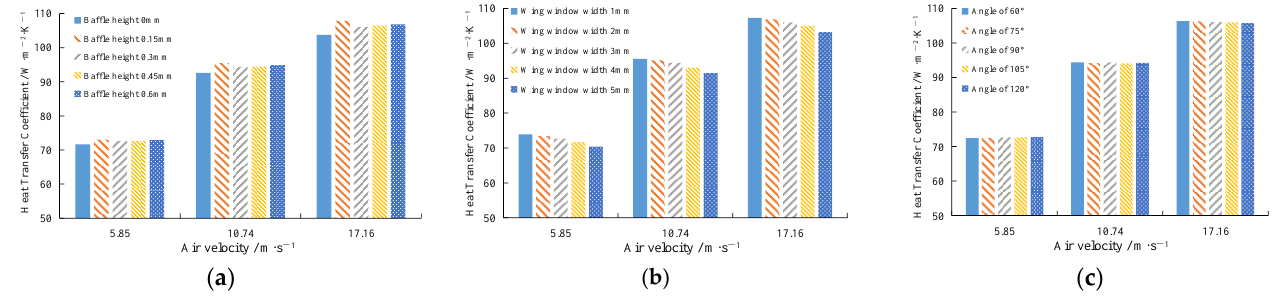
Figure 10. The influence of three factors on the heat transfer coefficient; ( a ) baffle factor; ( b ) wing window factor; ( c ) angle factor.